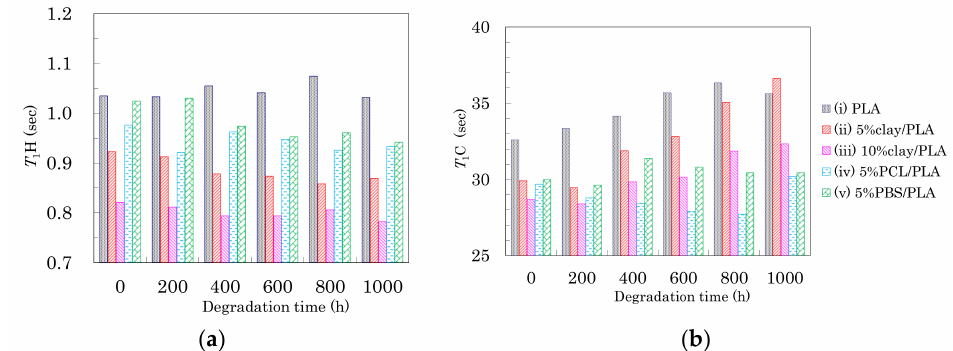
Figure 11. T 1 H values ( a ) and T 1 C values ( b ) of 4 DR PLA fibers plotted versus degradation time. The T 1 C values of the CH group in the PLA fibers are plotted versus degradation time in